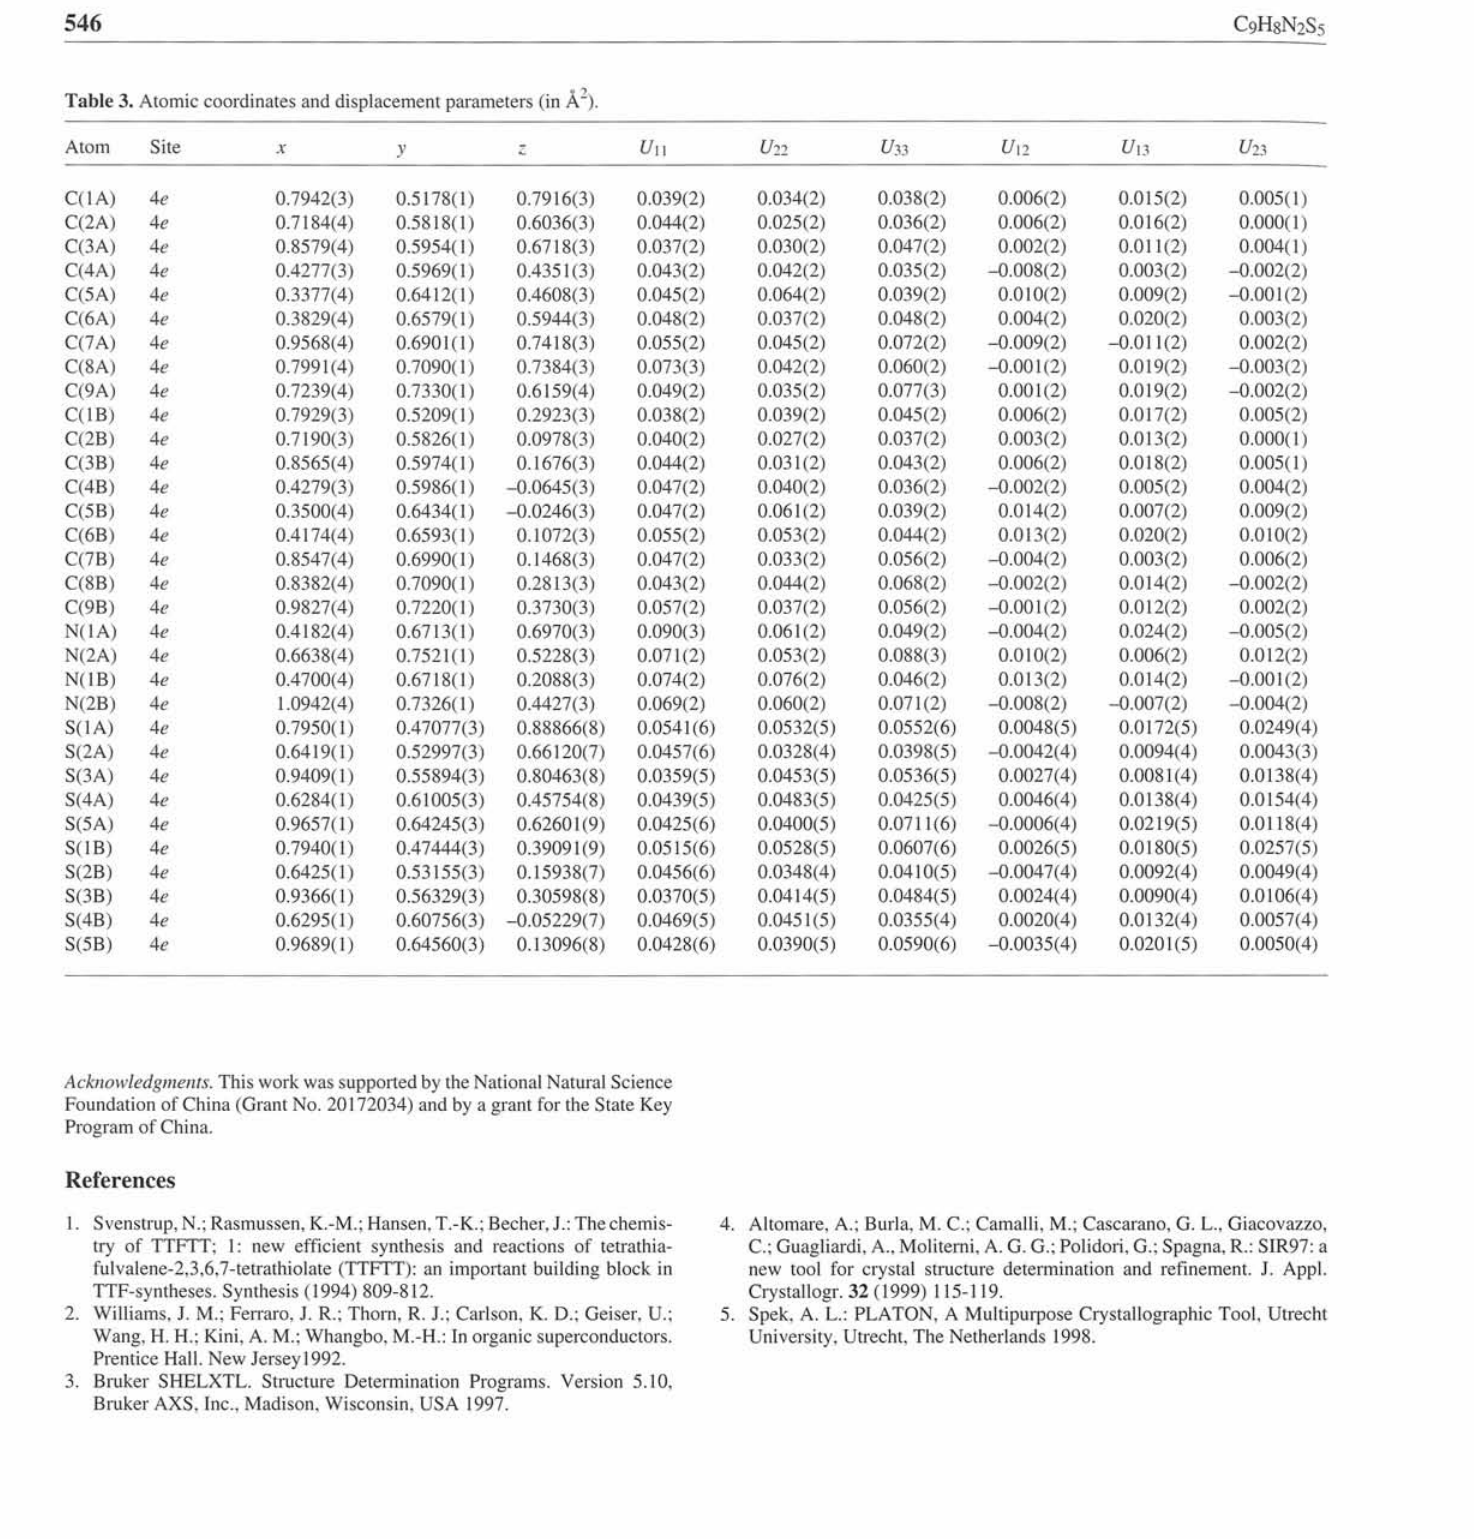
Table 3. Atomic coordinates and displacement parameters (in Â 2